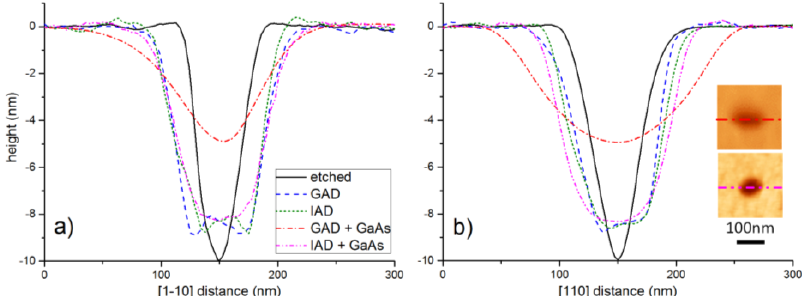
Figure 2. AFM line scans of hole profiles along ( a ) [1 1̅ 0] and ( b ) [110] after wet chemical etching, GAD, IAD, GAD followed by 10 nm GaAs, and IAD followed by 10 nm GaAs (each profile represents an average over 15–20 line scans). Inset of panel (b): AFM images of two holes after GAD and IAD,